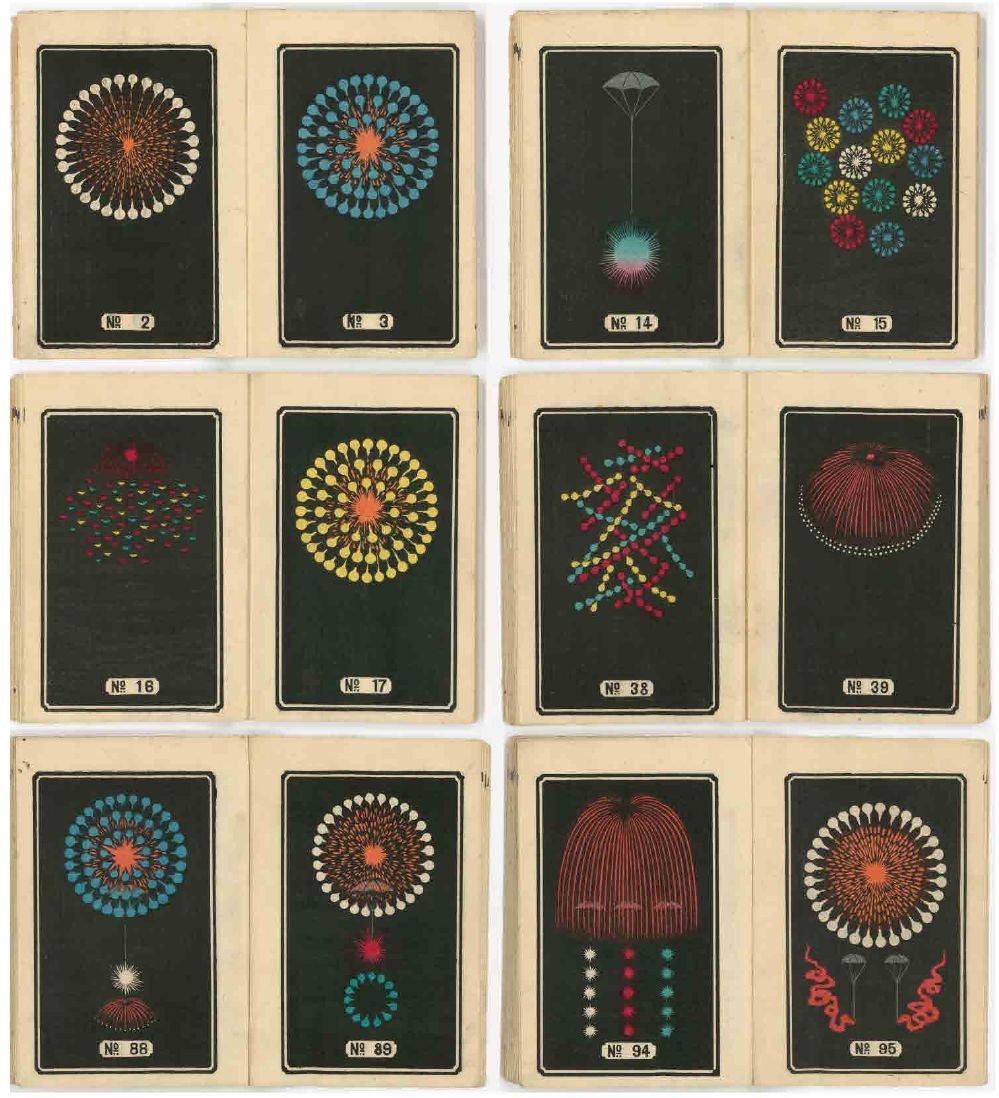
Fig. 8 Hirayama Fireworks,